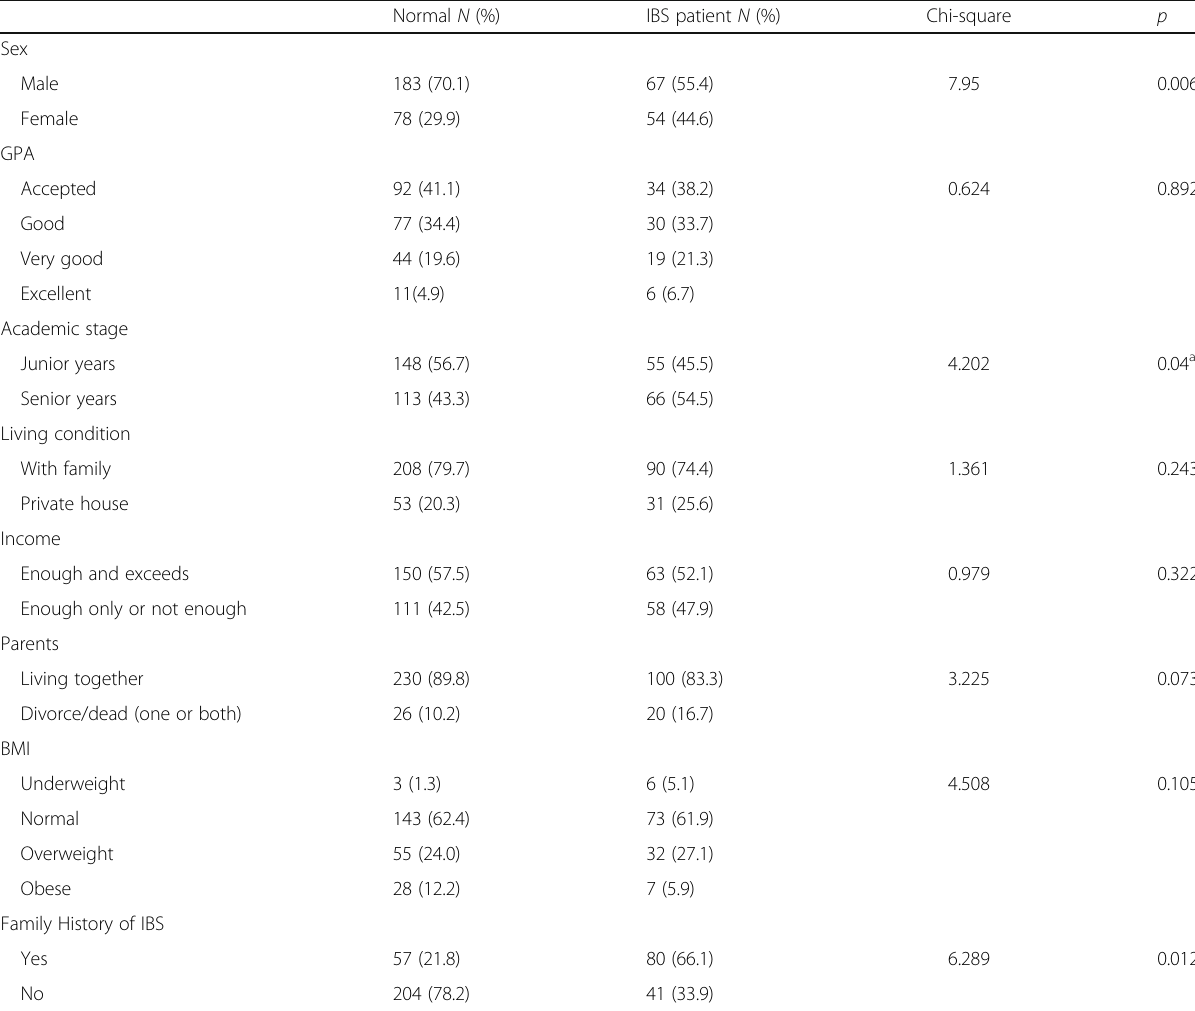
Table 1 Comparison between IBS patients and normal students regarding socio-demographic characteristics Normal N (%) IBS patient N